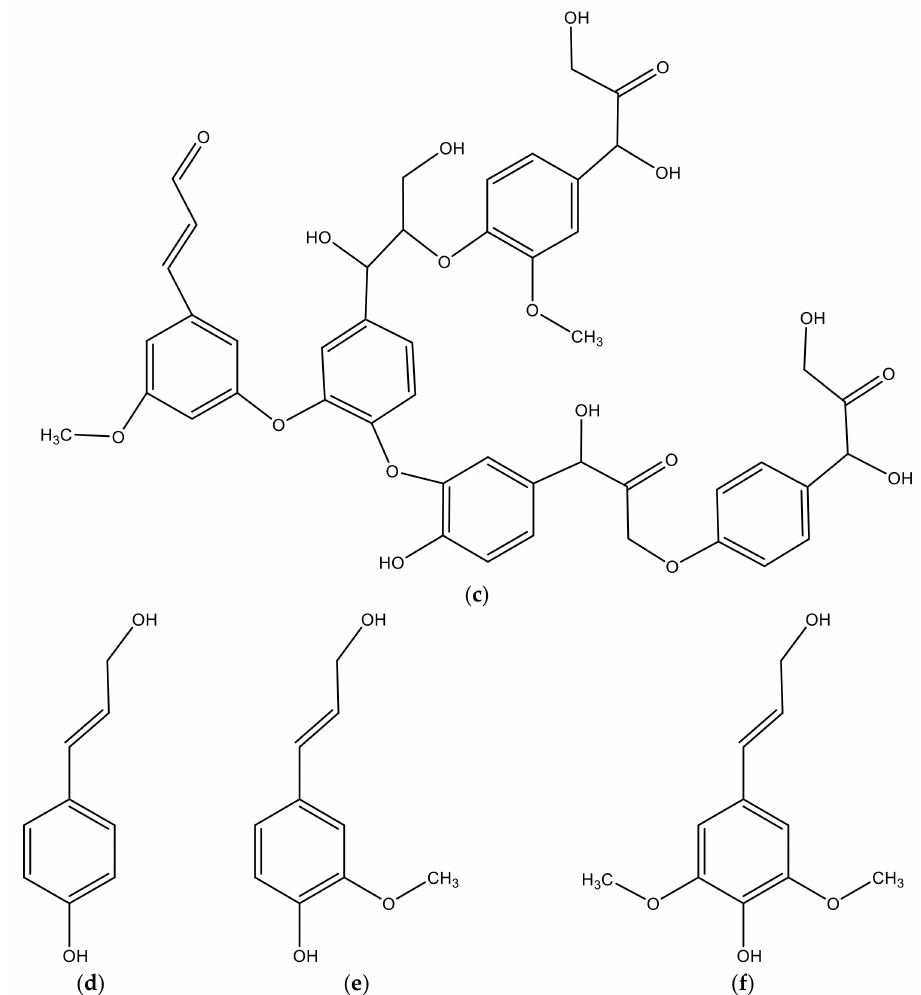
Figure 3. Chemical structures of biopolymers: ( a ) Cellulose, ( b ) hemicellulose, and ( c ) lignin; and monolignols: ( d ) P-coumaryl, ( e ) coniferyl, and ( f ) sinapyl